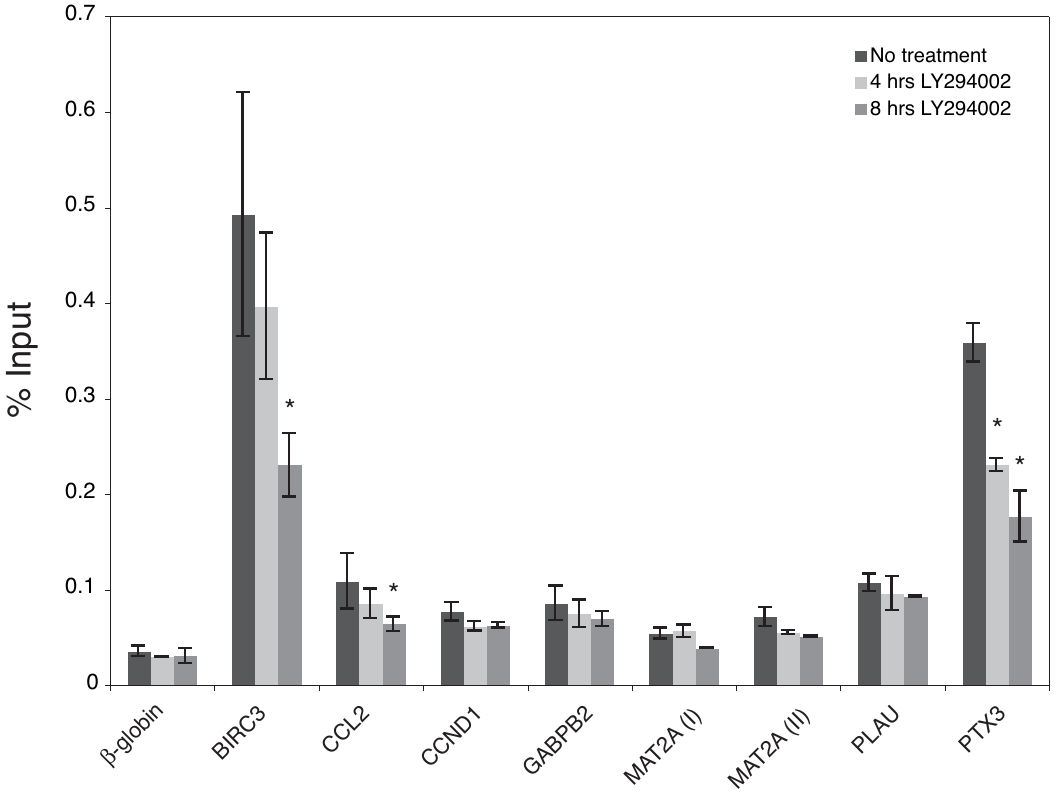
Figure 7 PI 3-kinase inhibition causes a decrease in RelB binding . T98G cells were either maintained in serum or treated with 50 M LY294002 for 4 or 8 hours. Chromatin fragments were immunoprecipitated with anti-RelB antibody and quantified by real- time PCR. Data are presented as the percentage of input and are the means of 3 independent experiments ± S.E. - globin was used as the negative control. (*) represents statistically significant loss of binding compared to the cells maintained in serum (assessed by t